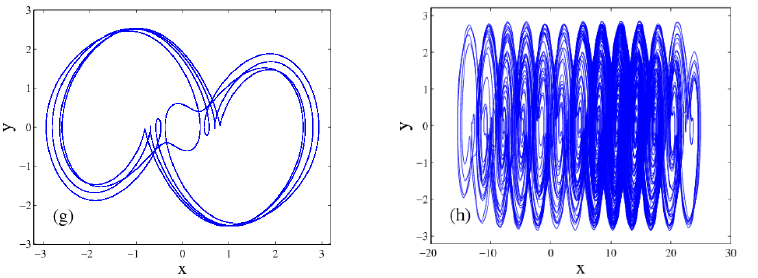
Figure 3. ( a ) Single scroll period-1 when c = 0.9; ( b ) single scroll period-2 when c = 0.95; ( c ) single scroll period-4 when c = 0.99; ( d ) single-scroll chaotic state when c = 1.1; ( e ) double-scroll chaotic state when c = 1.25; ( f ) double-scroll period-2 when c = 1.44; ( g ) double-scroll period-4 when c = 1.58; ( h ) multi-scroll chaos when c = 1.8.